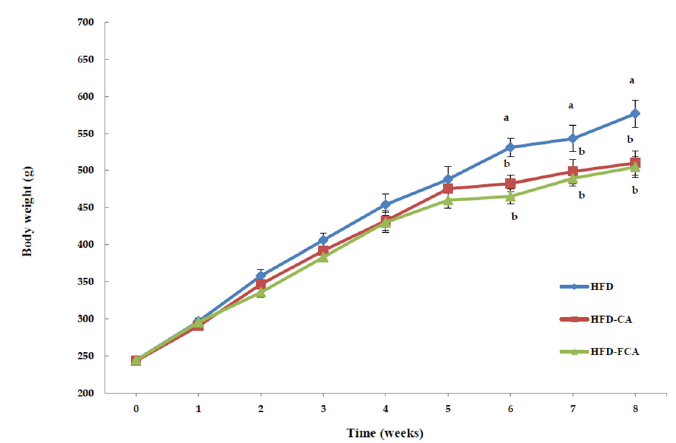
Figure 1. Body weight changes in rats fed experimental diets for 8 weeks. Body weight was measured weekly and presented as mean ± SE ( n = 8). a,b; Bars with different letters are significantly different at p < 0.05 by Tukey’s test. Diet groups; HFD, high fat diet group: HFD-CA, HFD + cabbage-apple juice administration group: HFD-FCA, HFD + fermented cabbage-apple juice administration group.